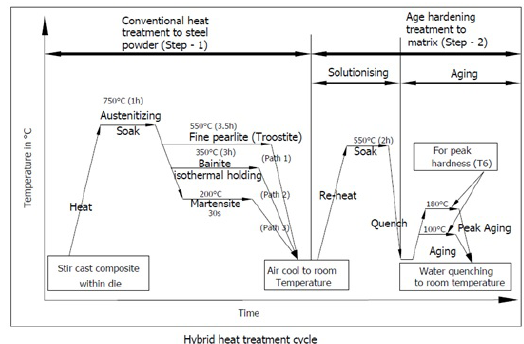
Figure 3. Hybrid heat treatment for the matrix and